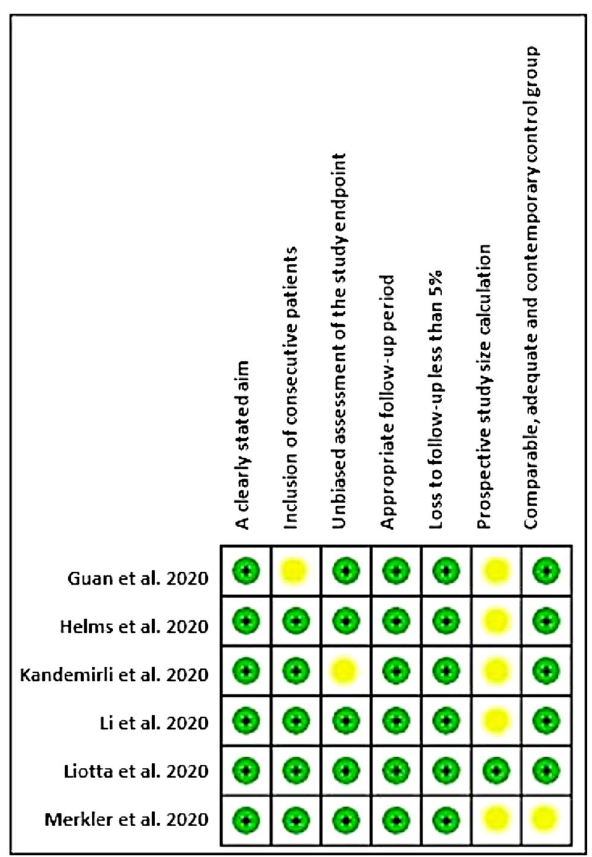
Fig. 2 Risk of bias among the studies included in this study, accord- ing to the authors' judgements